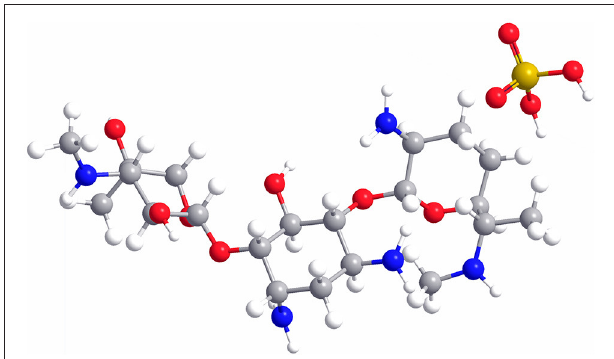
FIGURE 1 | Molecular structure of GS. C, gray; H, white; O, red; N, blue; S,